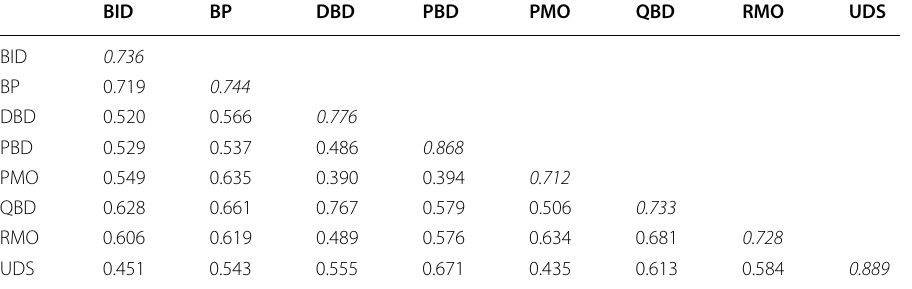
Table 2 Discriminant validity